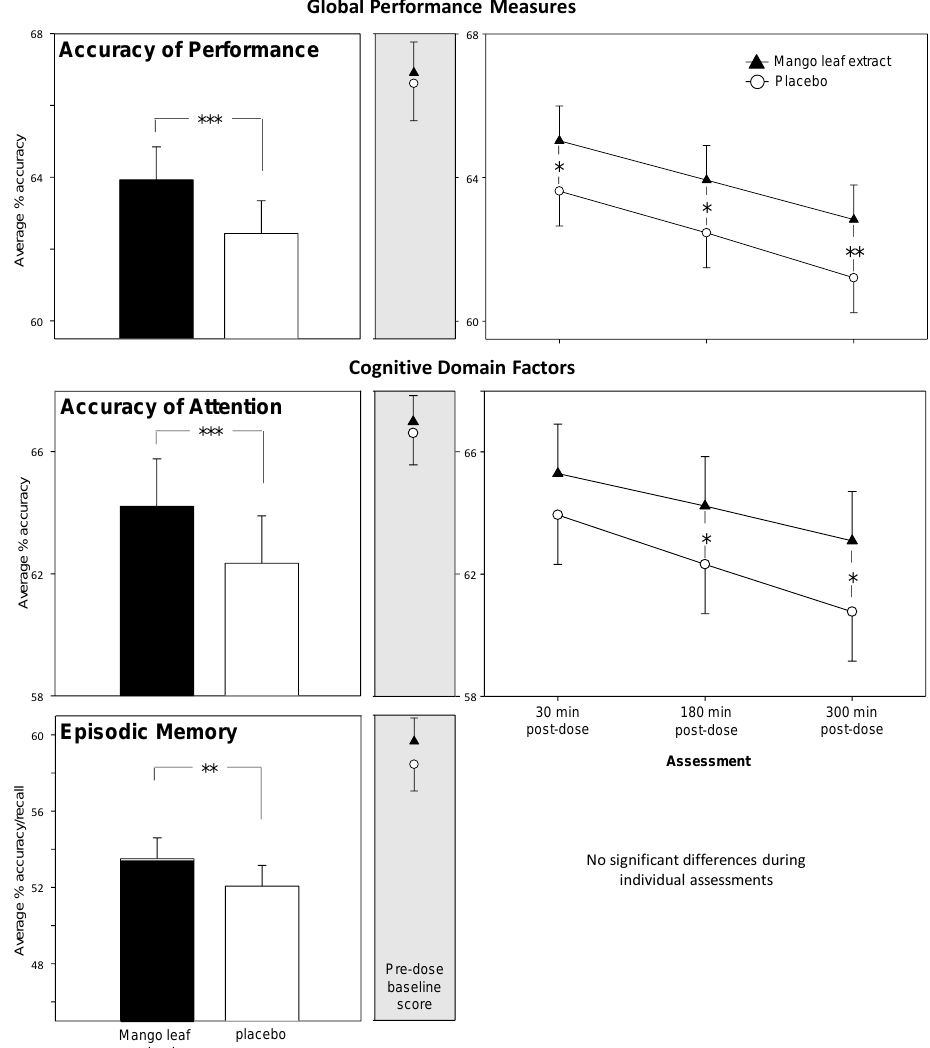
Figure 4. The effects of mango leaf extract on the global outcome measures and factor scores derived from the Computerised Mental Performance Assessment System (COMPASS) cognitive tasks. Left-hand panels show the main effect of treatment averaged across assessments; middle panels show the pre-dose baseline scores; right-hand panels show time course data from each post-dose assessment for those measures that saw significant effects on the planned comparisons (Bonferroni). The global Accuracy of Performance measure represents averaged data from the eleven tasks from the battery that return % accuracy/maximum score data: Accuracy of Attention represents averaged % accuracy data from the five attention tasks; and Episodic Memory represents averaged % accuracy/recall across the four long-term memory tasks. *, p < 0.05; **, p < 0.01, ***, p < 0.001 versus placebo. Number of participants contributing to the measure: Accuracy of Performance, n = 68, Episodic Memory, n = 70, Accuracy of Attention, n = 64.